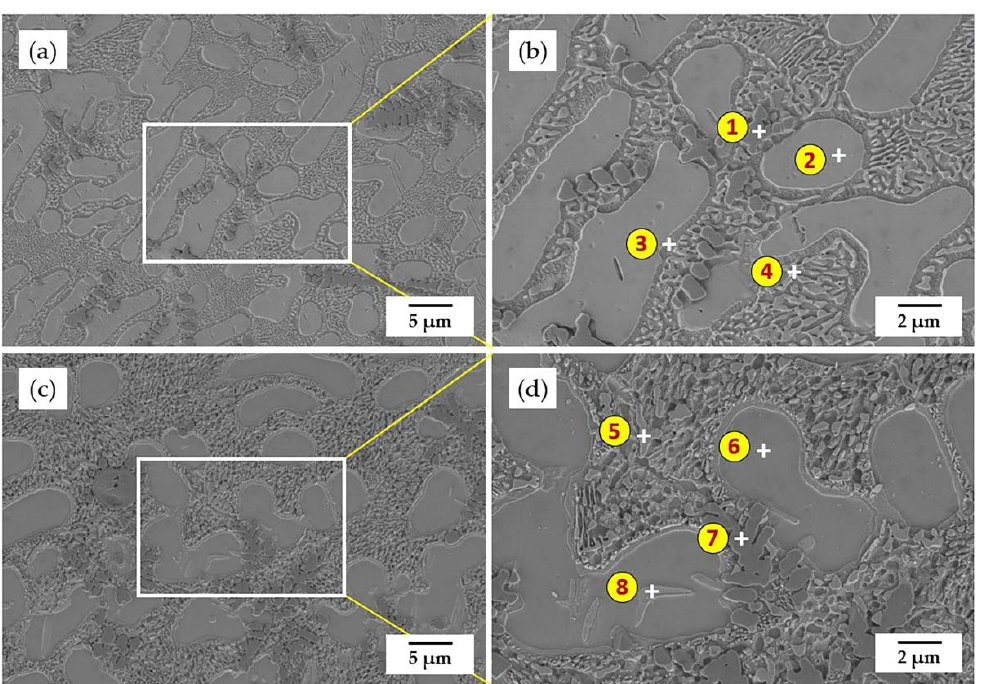
Figure 7. SEM morphology of the coating after annealing under 850 °C: ( a ) ( b ) keep 0.5 h; ( c ) ( d ) keep 2 h.